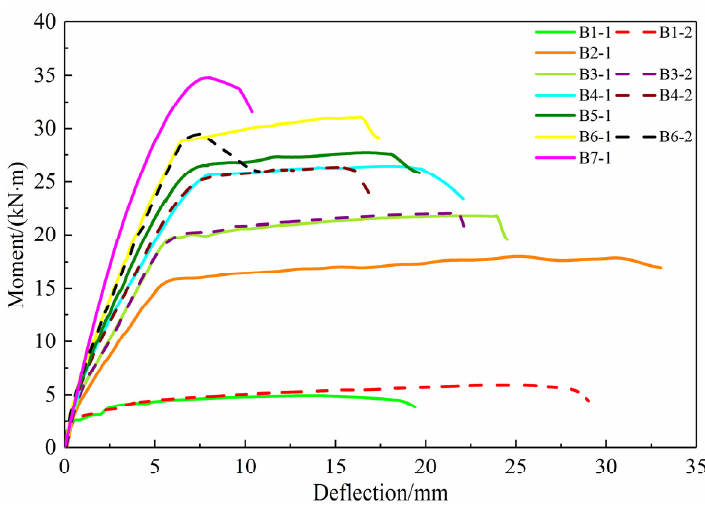
Figure 5. Moment–deflection curves for different types of concretes and reinforcement ratios.